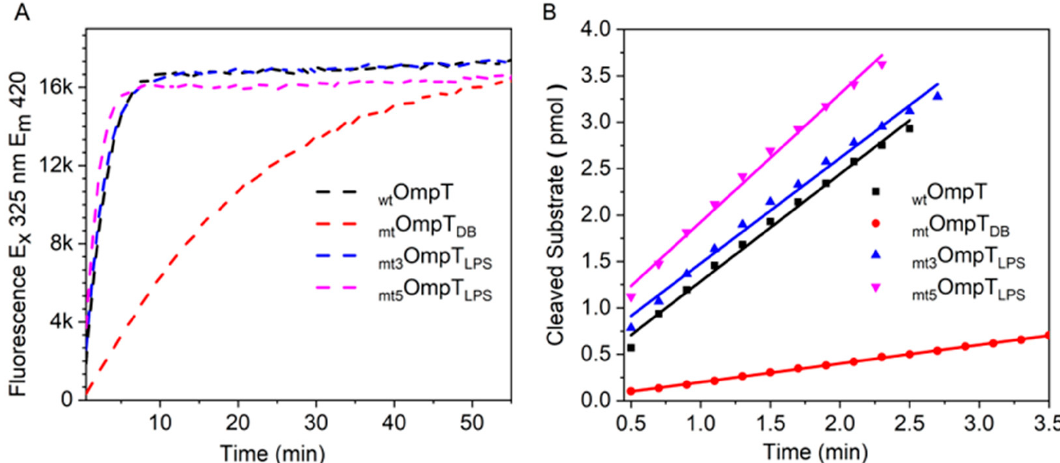
Figure 7. Comparison of enzyme activities of the four OmpT variants (OmpT, mt OmpT DB , mt3 OmpT LPS , and mt5 OmpT LPS ): ( A ) FRET-based activity measurements; ( B ) initial velocity measurements used to calculate specific activity, Table 1.